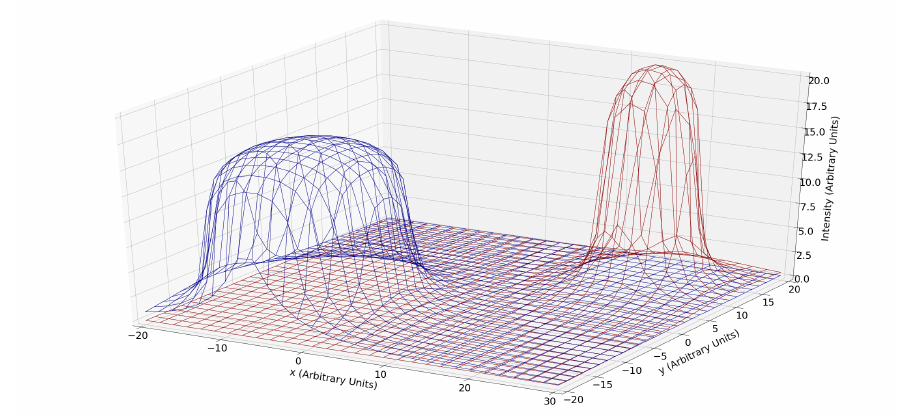
Figure 2. 3D visualization of a randomly generated intensity space with two tasks on a 2D field (blue and red) with different radii and different number of